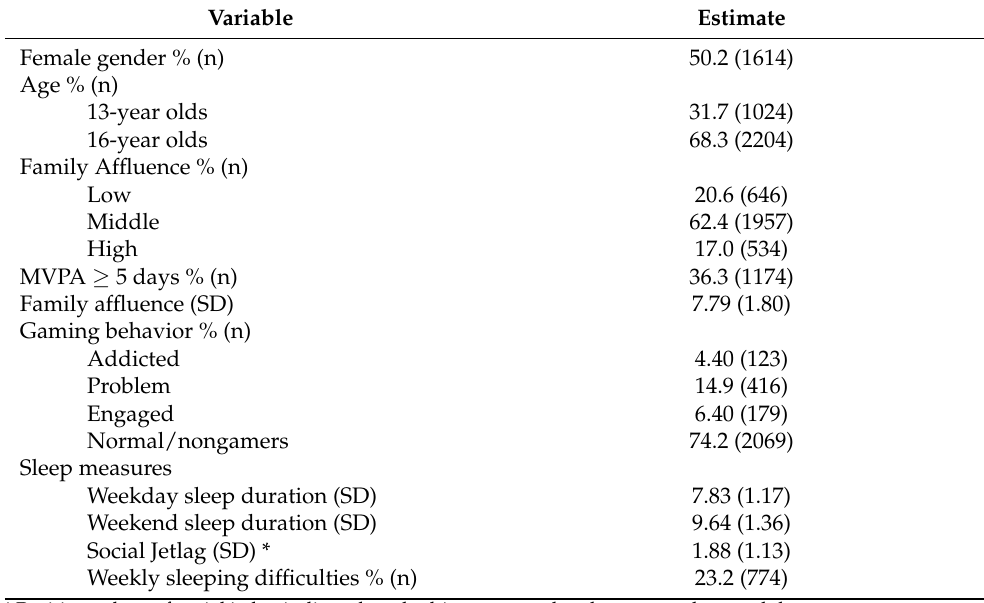
Table 1. Baseline characteristics. Variable